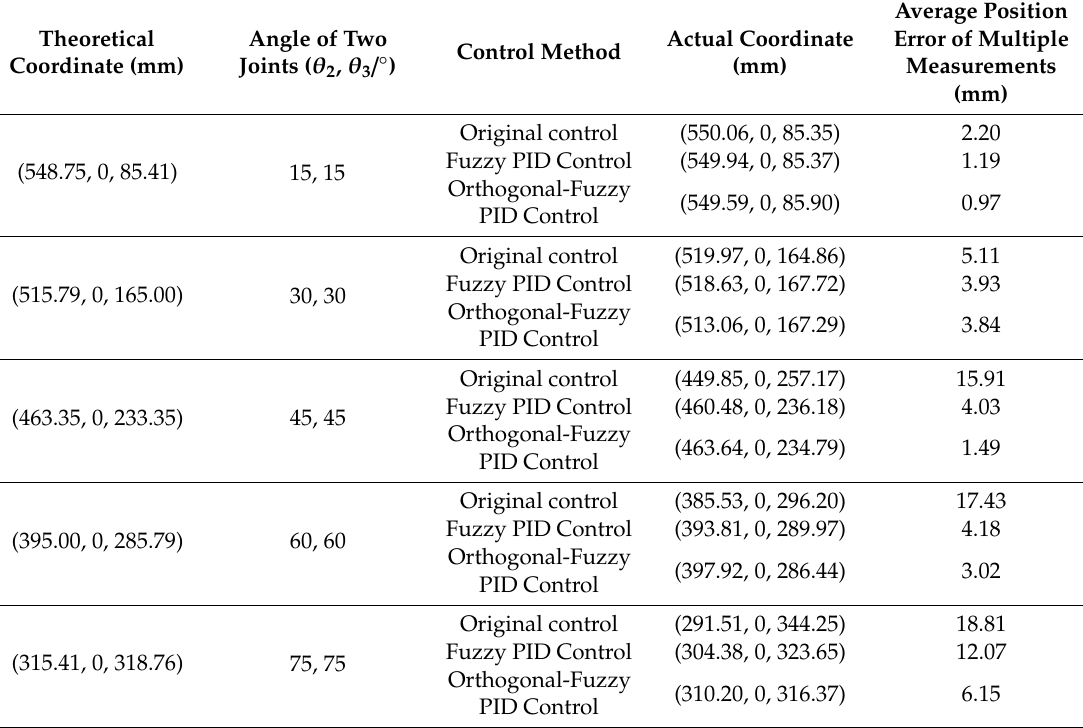
Table 10. Positioning error of the two-degrees-of-freedom manipulator.